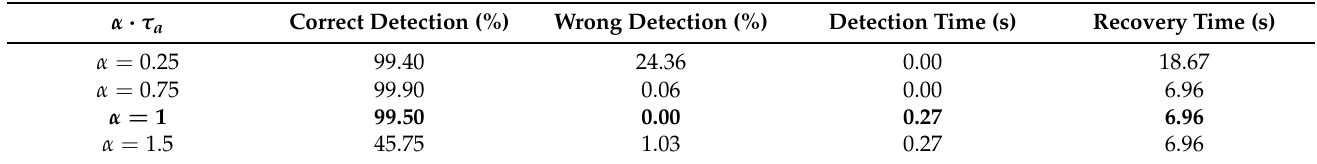
Table 5. Sensitivity analysis for varying of τ a .